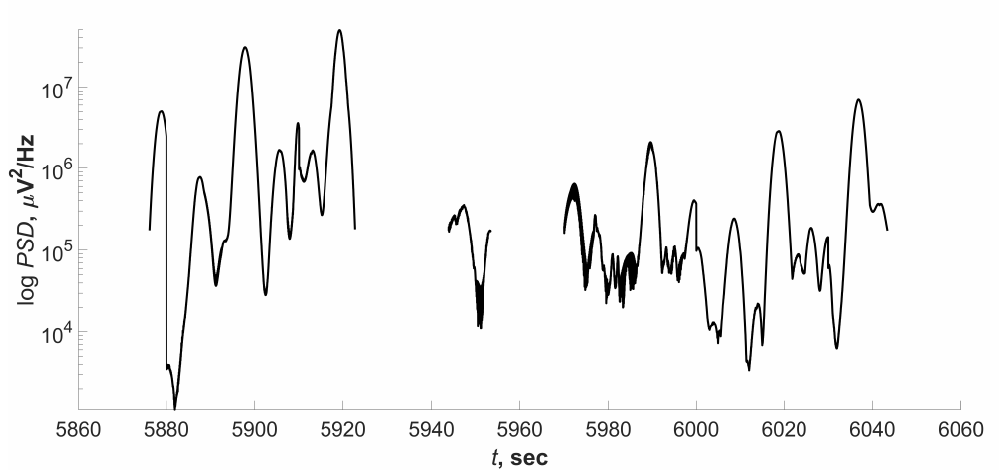
Figure 6. The segmented wavelet spectrogram ridge of the EEG signal fragment typical for ES. The upper figure shows a segmented ridge PSD r , the bottom one shows f r .